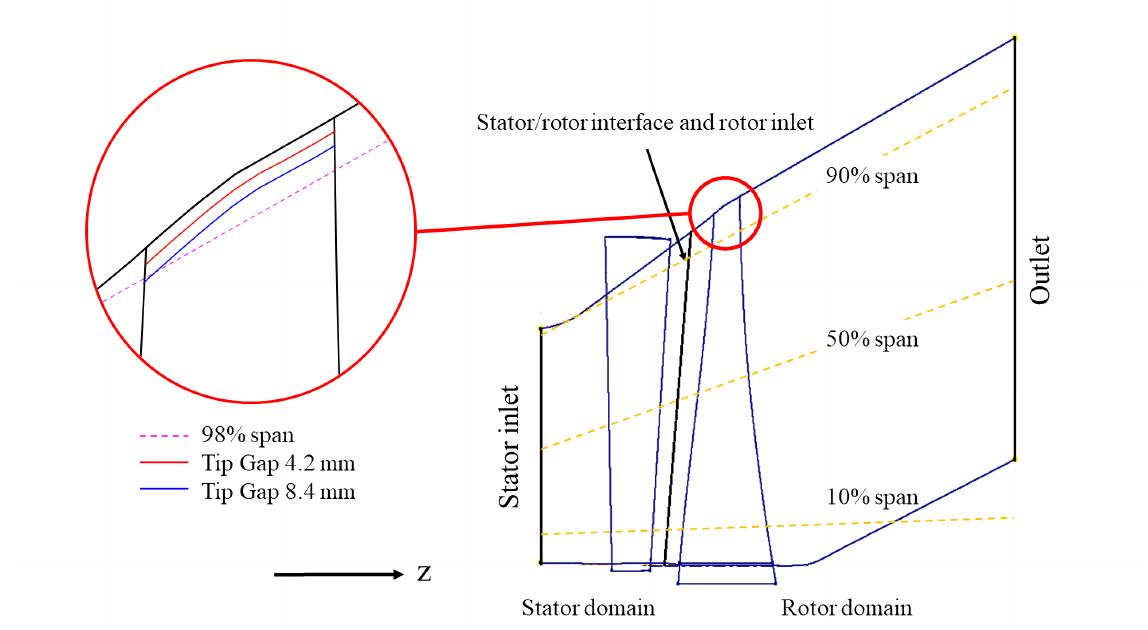
Figure 1. Schematic figure of the steam turbine model with span lines and the location of the rotor blade